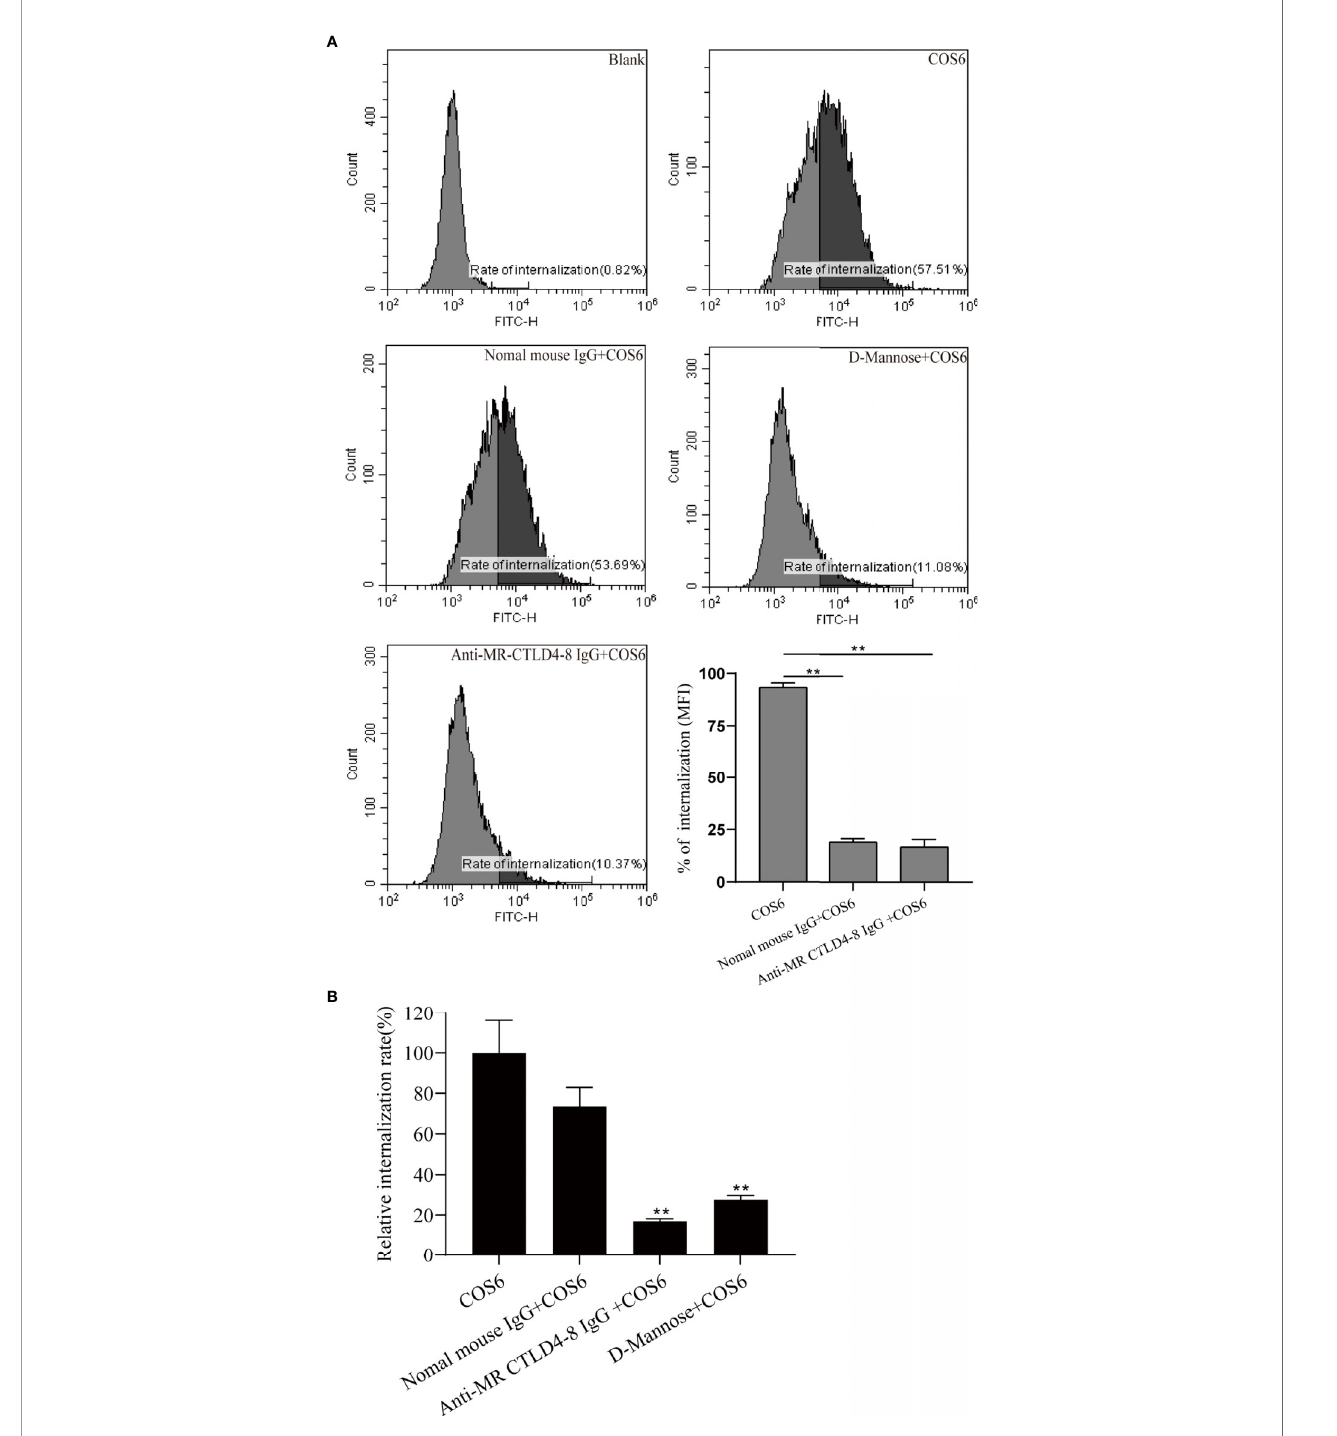
FIGURE 4 | Internalization of fl uorescein isothiocyanate (FITC)-chitooligosaccharide hexamer (COS6) by macrophages with or without blocking mannose receptor (MR) CTLD4-8. Anti-MR CTLD4-8 (4 m g/ml) and D-mannose (2 mg/ml) blockade of the cells for 2 h, and the macrophages were incubated with FITC-COS in a six- well plate at 28°C for 30 min. (A) The internalization rate of FITC-COS6 by fl ow cytometry. The mean fl uorescence intensity (MFI) of internalization in macrophages was recorded. (B) Inhibitors of MR binding and function block the association of COS with primary macrophage. Cells were preincubated with 2 mg/ml D-mannose, mannose receptor C-type lectin-like domain 4-8 of Megalobrama amblycephala (MaMR-CTLD4-8) speci fi c antibody, negative IgG, or medium alone. Then, 0.05 mM FITC-COS6 was added, and cells were incubated, washed, lysed, and mixed uniformly. Fluorescence intensity was measured. Data were shown as means ± SD and collected from three independent experiments, with (*) p < 0.05 and (**) p < 0.01 vs. the COS6 group (set as